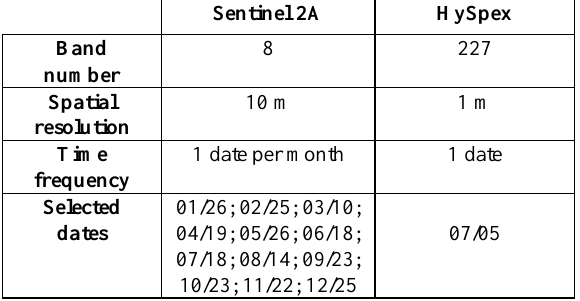
Table 1 . Characteristics of preprocessed